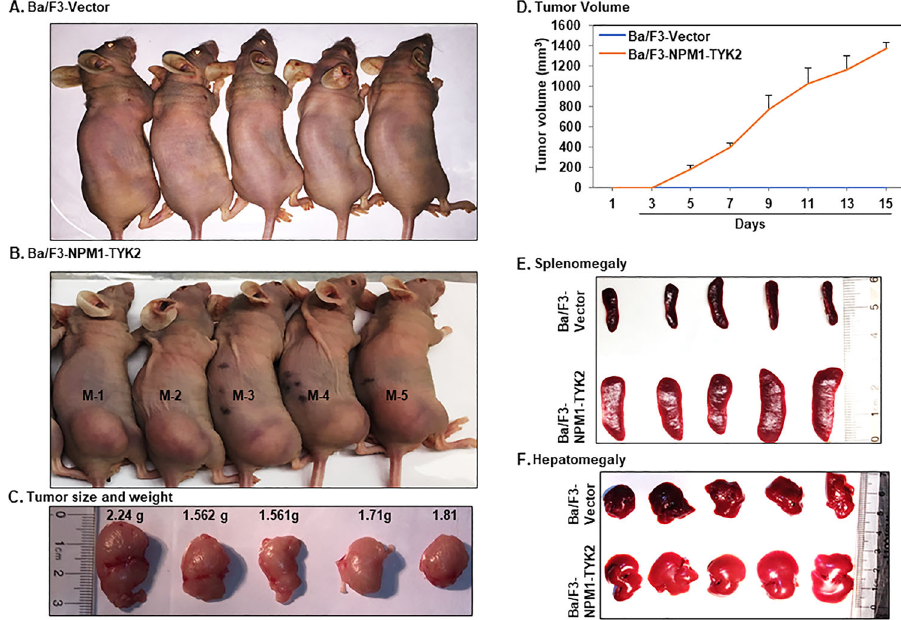
Fig. 4 In vivo tumorigenic potential of the NPM1 – TYK2 fusion gene. A Representative image of mice ( n = 6) subcutaneously injected with Ba/F3-Vector showed no tumors. B Representative images of mice ( n = 6) subcutaneously injected with transformed Ba/F3 – NPM1 – TYK2 show tumorigenesis. C Representative images of resected tumors with their respective tumor weight (grams). D Tumor volume was increased signi fi cantly in transformed Ba/F3 – NPM1 – TYK2 injected mice but not in Ba/F3-Vector mice. Bars represent the SEM. E , F In transformed Ba/F3 (NPM1 – TYK2) mice, tumor growth was associated with hepatosplenomegaly.